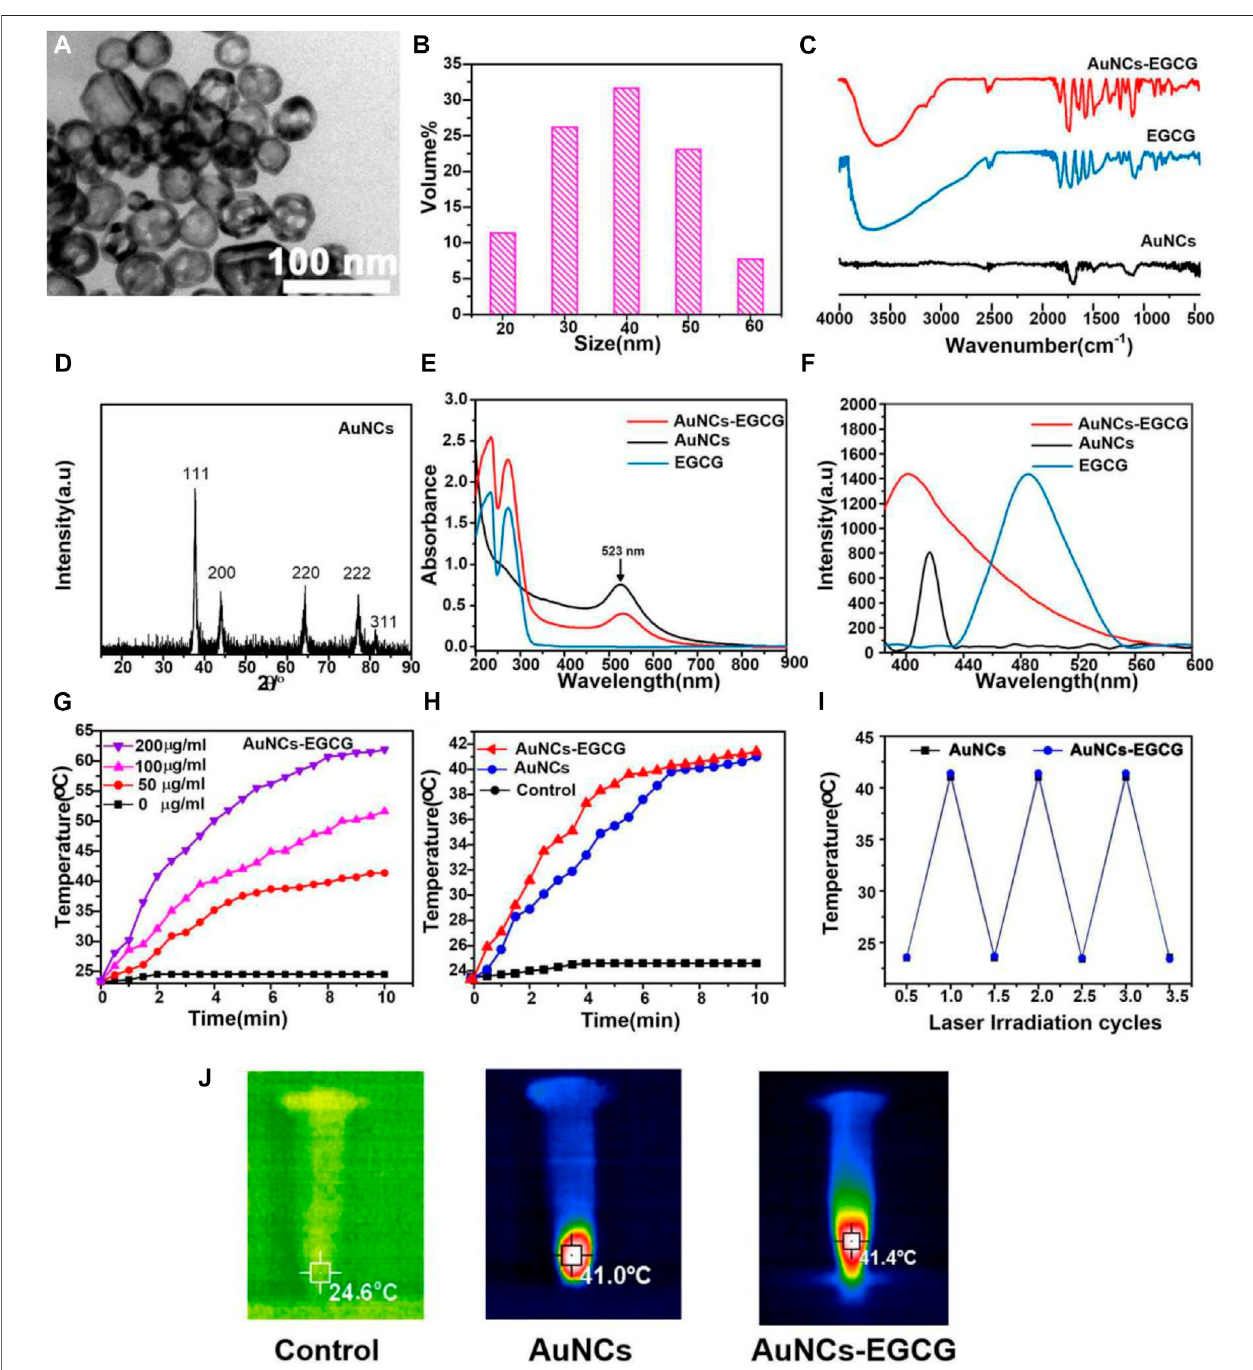
FIGURE 1 | Characterization of AuNCs and EGCG-AuNCs. (A) TEM images and (B) DLS size distribution of AuNCs. (C) FTIR spectra, (D) XRD, (E) UV-vis and (F) fl uorescenceemission( λ ex=400 nm)ofsamples. (G) TemperaturerisecurvesofAuNCs-EGCGatdifferentconcentrationswithin10 min. (H) Temperaturerisecurvesof three groups of samples within 10 min. (I) The thermal curves of AuNCs and EGCG-AuNCs after repeated laser irradiation ( n = 3). (J) Infrared thermography images of samples under 808 nm laser irradiation for 5 min.